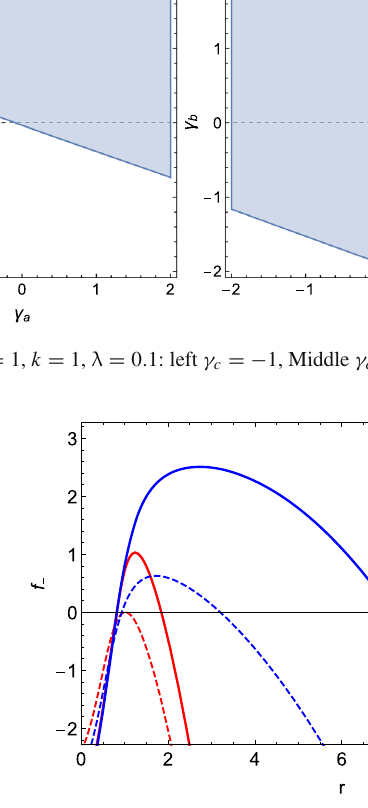
Fig. 3 Plot of f − when a ∗ = 1 , k = 1 Red: L = 1 , λ = 0 . 2 ,γ c = 1 (dashed) γ a = 0 ,γ b = 0 (solid) γ a = 0 . 6 ,γ b = 0 . 5 and Blue: L = 3 , λ = 0 . 015 ,γ c = 0 . 5(dashed) γ a = 0 ,γ b = 0(solid) γ a = 1 . 6 ,γ b = 0 . 8. The subplot displays a close up behavior of metric function f